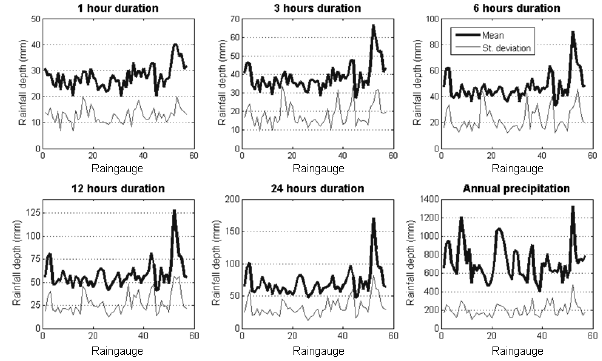
Figure 2. Statistical characteristics in term of mean value and standard deviation of the annual 2 Fig. 2. Statistical characteristics in terms of mean value and stan- maximum rainfall for 1, 3, 6, 12 and 24 hours duration and of the total annual precipitation for 3 dard deviation of the annual maximum rainfall for 1, 3, 6, 12 and each raingauge station. 4 24h duration and of the total annual precipitation for each rain gauge